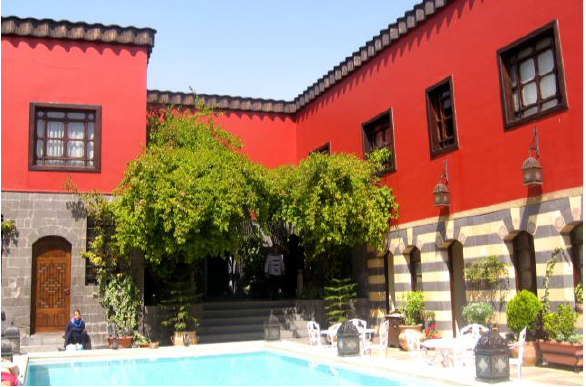
Figure 11. Courtyard of Talisman Hotel, Archive Ifpo, 2010.